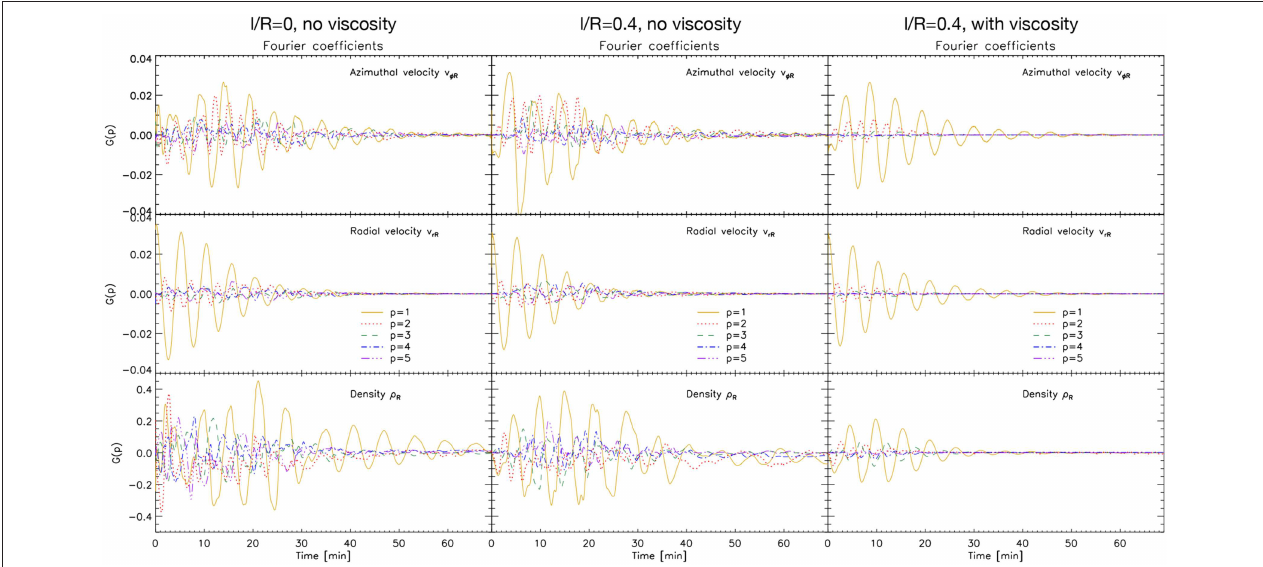
FIGURE 7 | Fourier coefficients for the azimuthal and radial velocities and the density. We show the contribution of the azimuthal modes to each quantity along an ellipse fitting the edge of the loop by calculating the Discrete Fourier Transform (Equation 9). We only show the first 5 modes (see legend for line